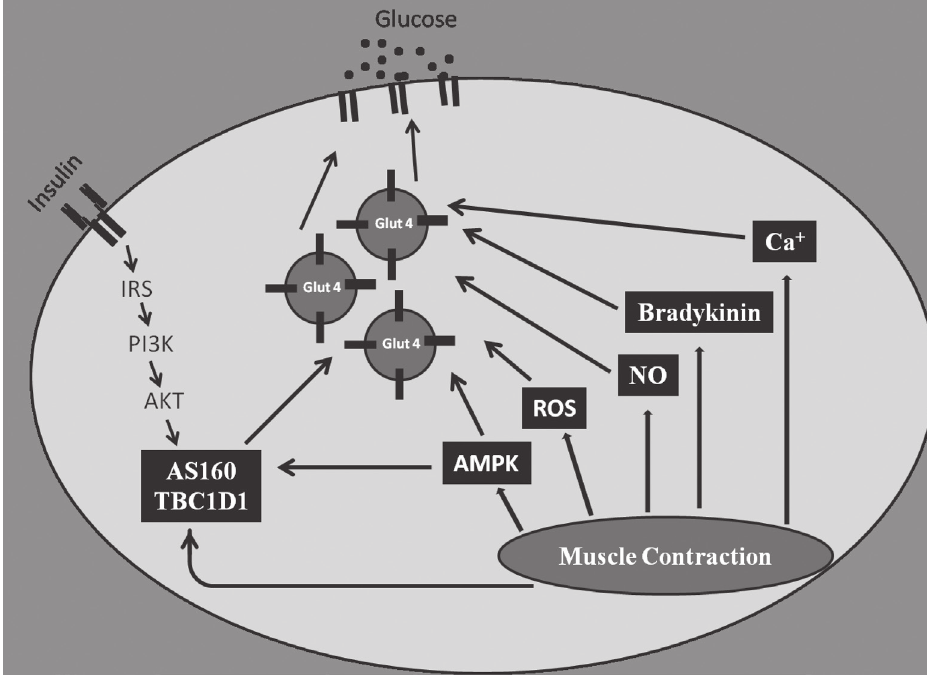
Figure 2 - Muscle contractions cause translocation of the glucose transporter proteins (GLUT4) to the cell membrane. Contraction activates a number of signaling proteins that might be involved in the exercise signaling mechanism [e.g., AMP-activated protein kinase (AMPK), calcium, nitric oxide (NO), bradykinin, Akt substrate of 160 kDa (AS160), TBC1D1 and reactive oxygen species